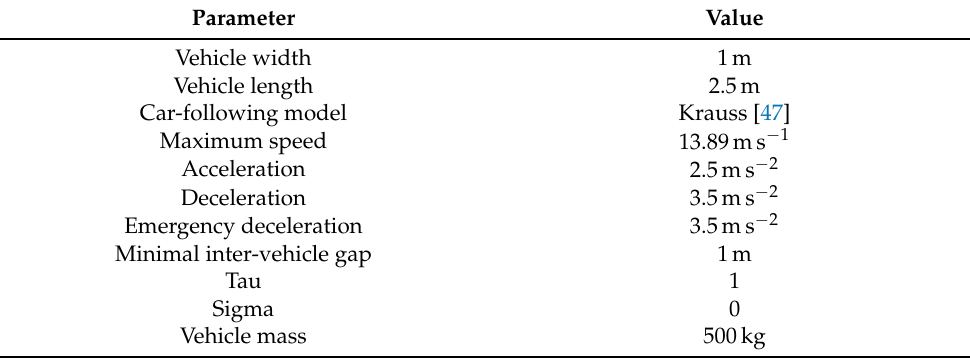
Table 2. Parameterization of the vehicles and the corresponding car-following